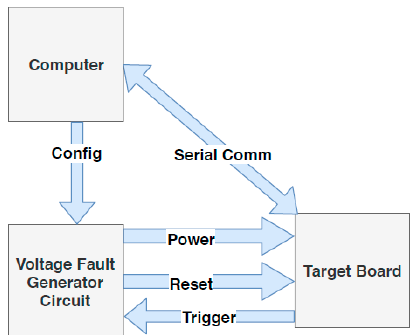
Figure 8. Fault injection set-up for voltage fault attack.